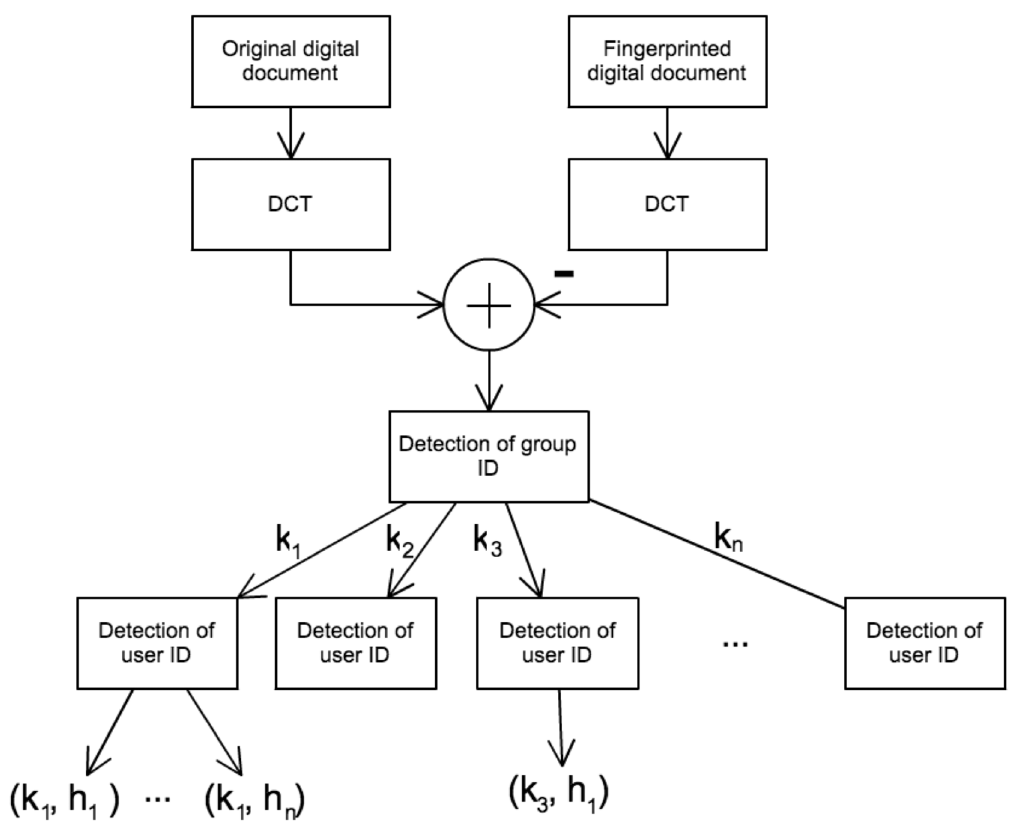
Figure 11. Diagram of fingerprint detection method.